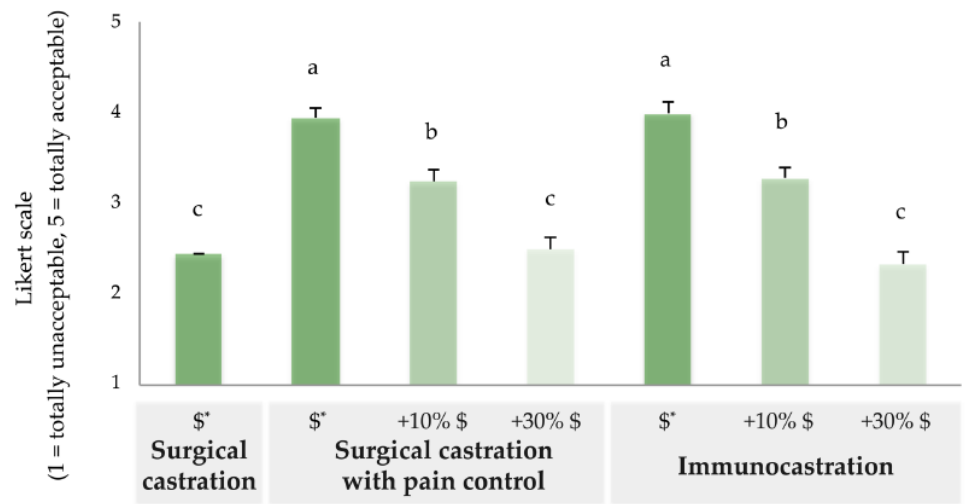
Figure 2. Acceptability of piglet castration methods and influence of change in price (Sv1, n = 441. $* = price not mentioned; +10%$ and +30%$ = increase compared to current price). Different letters indicate p < 0.05.